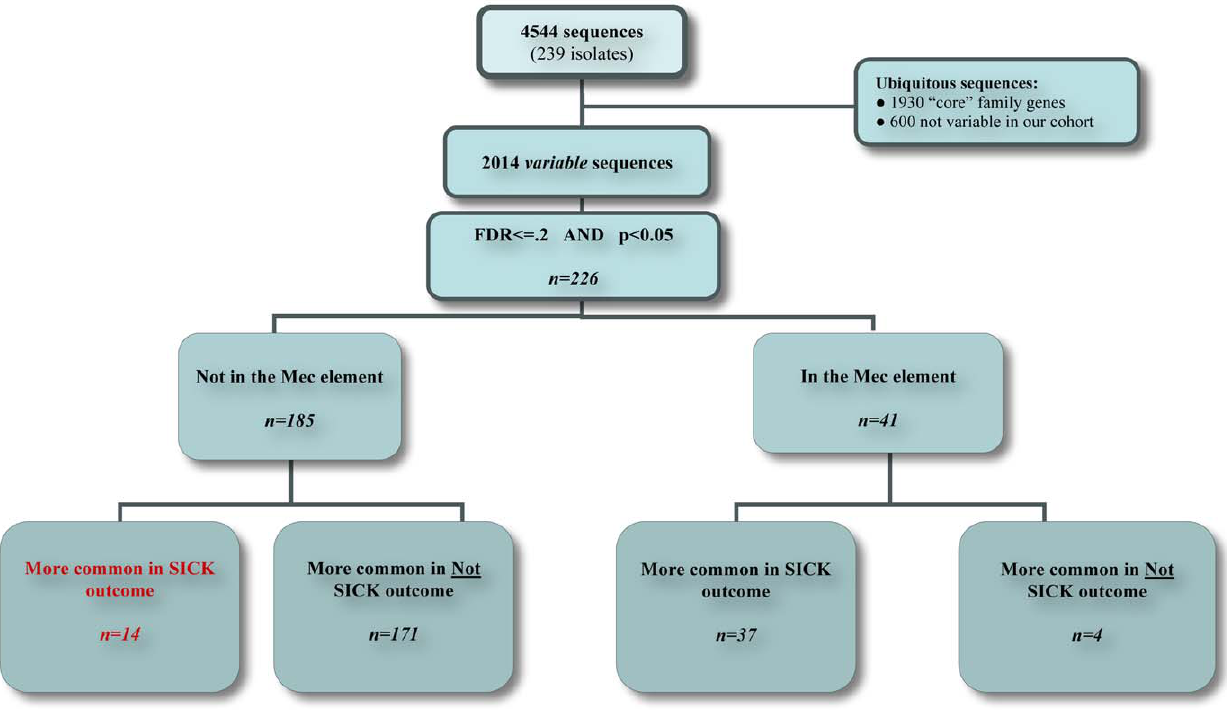
Figure 1. Disposition of 4544 aCGH probes. This figure illustrates how we arrived at our candidate genes of interest. Of the 2014 sequences and 239 isolates, a total of 226 sequences were statistically significant after multiple comparisons adjustment. Of these 226 sequences, 185 were not and 41 were in the SCC mec element. Most of the 185 non-SCC mec genes-171-were significantly less common in the complicated infection group. The remaining 14 genes were significantly more common in isolates from the complicated infection group. Among the 41 SCC mec element genes, 37 were significantly more common in the complicated group and 4 were significantly less common in the complicated group. Therefore, a total of 51 of the 2014 sequences, 14 non-mec associated and 37 mec associated, were identified as genes of interest.